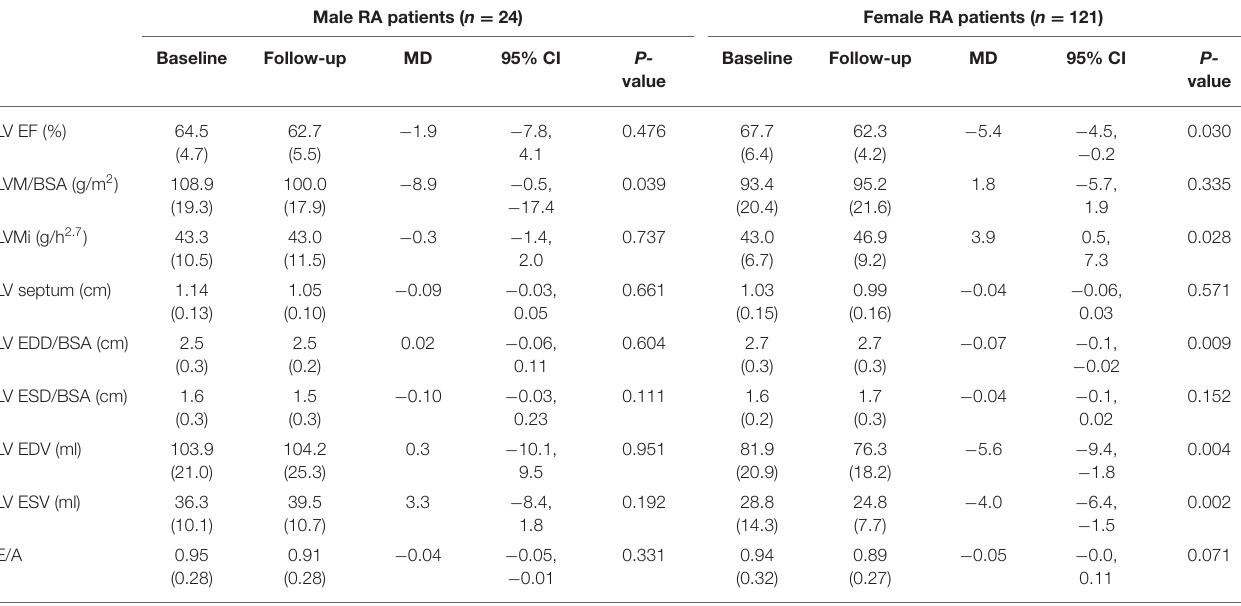
TABLE 2 | Changes in echocardiography measures at follow-up.